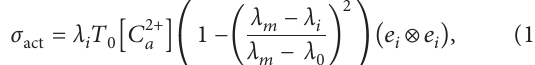
Figure 2: Lumped parameter model of the posterior cerebral artery (PCA) and its distal arteriolar and venous beds. P entry, intracranial, and venous exit blood pressure. P P : output pressure of the PCA. P a and P v : central and venous blood pressure. Qai and QLp: PCA input and inertia flow. Q a and Q v : venous entry and exit streams. C p , L p , and R p : PCA compliance, inertia, and resistance, 0 respectively. c a and R a : arteriolar compliance and resistance. c v and R v : venous compliance and resistance. Posterior cerebral